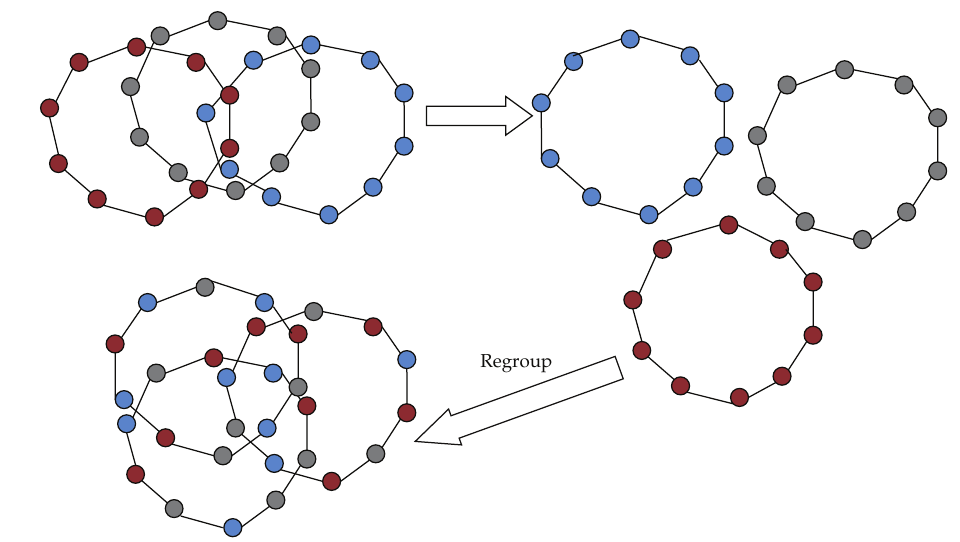
Figure 1: DM-PSO-ABC’s configuration of small